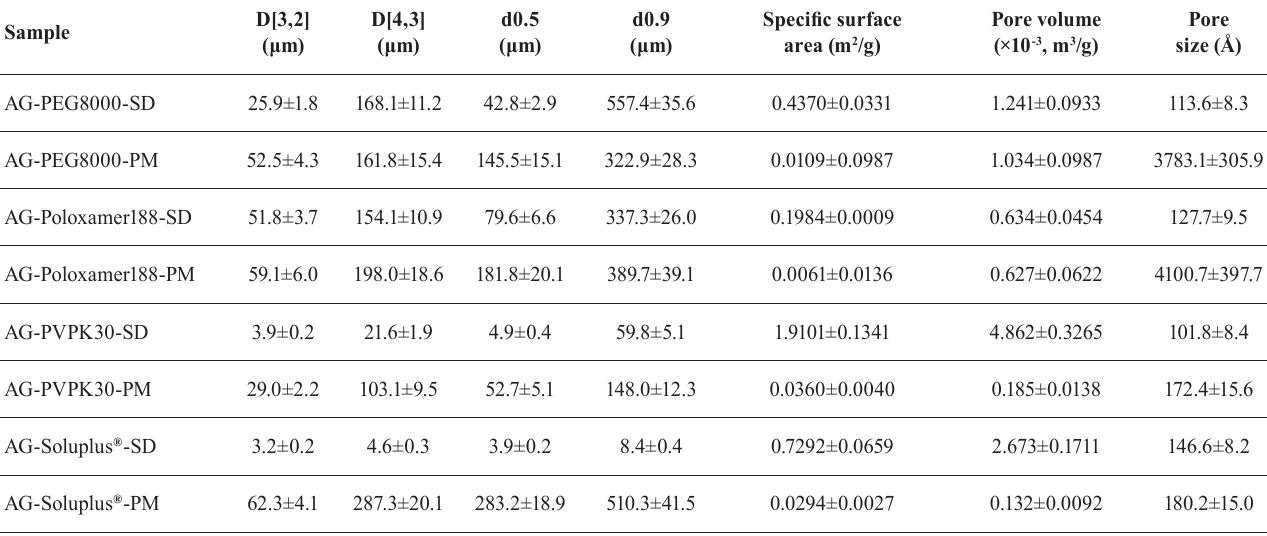
TABLE III - Particle size, specific surface area and pore volume of SD and PM